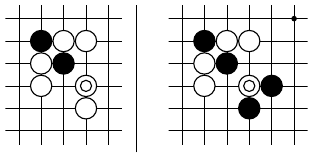
Figure 2. White’s play in this figure follows Pattern Attack1 in Figure 1. However, in the first diagram, White’s move is unnecessary and inefficient, and, in the second diagram, the move does not work because of the combined effect of Black’s stones below and to the right. These two examples showcase one of the main challenges in preprogramming Go patterns into an